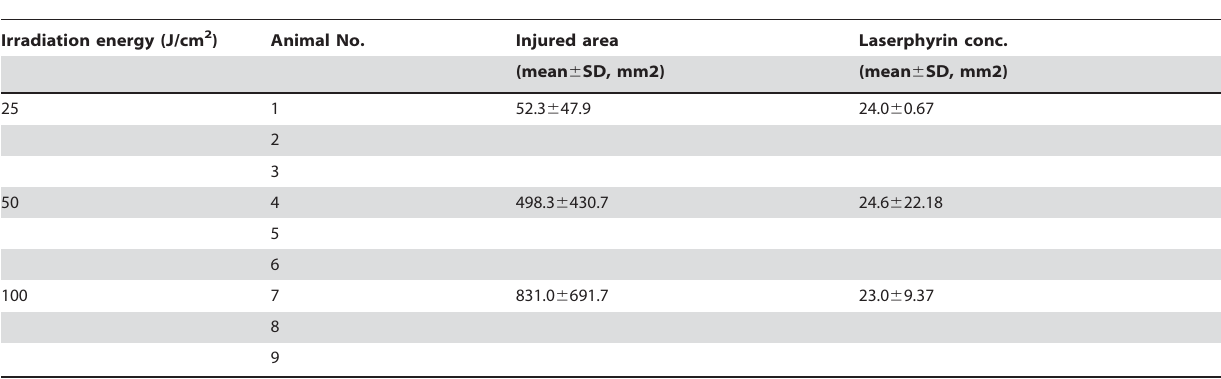
Table 1. The injured areas and serum concentration of Laserphyrin.